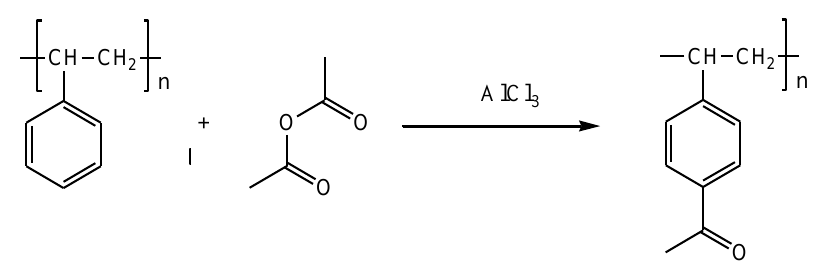
Figure 2. Modification of polystyrene by acetylation.